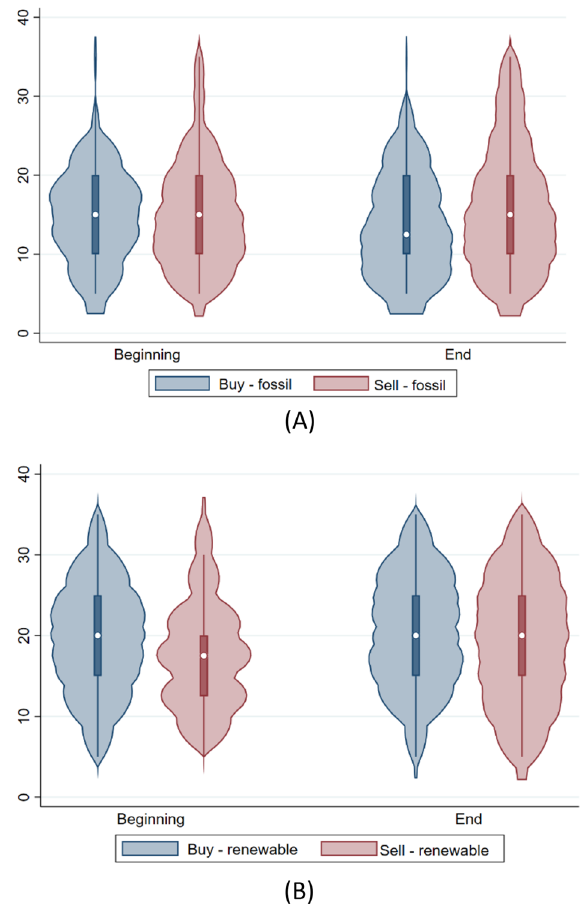
Figure 3. WTP values for the purchase and sale of energy produced from fossil sources ( A ) and renewable sources ( B ).